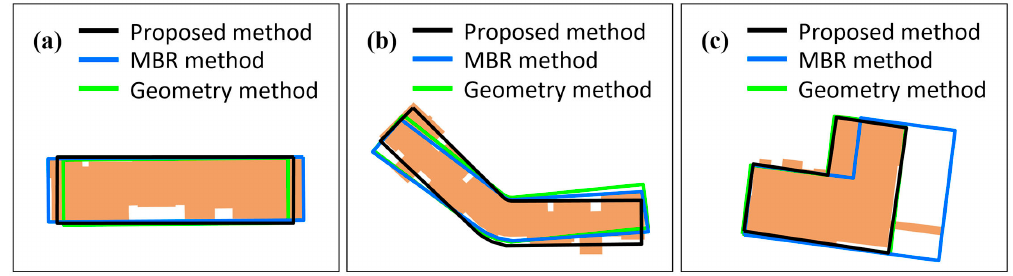
Figure 12. A visual analysis of the compared experiments: ( a ) a case where the minimum boundary rectangle of a polygon is close to the shape, ( b ) a case where the minimum boundary rectangle of a polygon is quite different from the shape, and ( c ) a case with a slender enation on the outline.